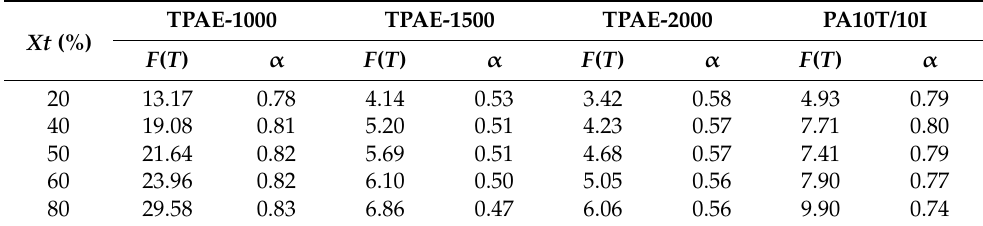
Figure 12. Plots of lgR versus lgt for TPAE-1000 ( a ), TPAE-1500 ( b ), TPAE-2000 ( c ) and PA10T/10I ( d ). Table 6. Parameters of crystallization kinetic based on Mo’s